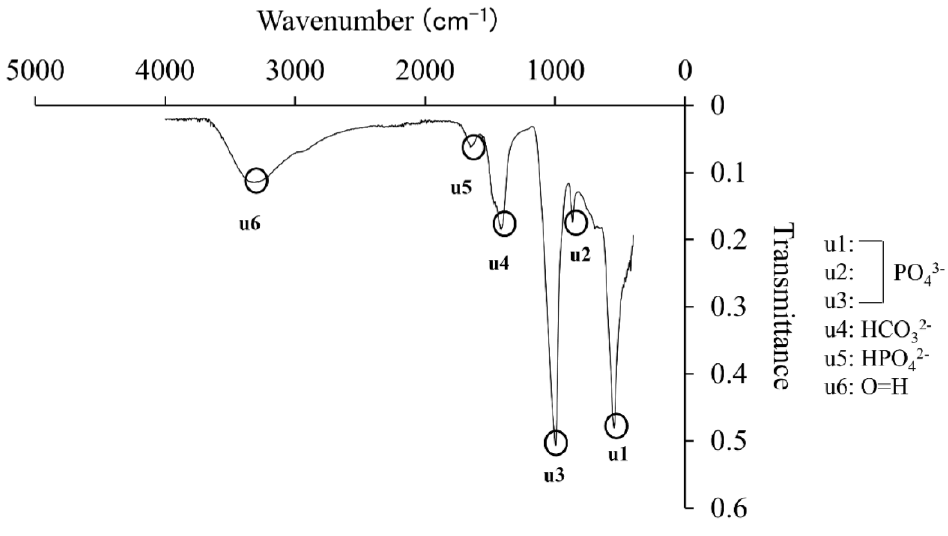
Figure 6. FT – IR analysis of precipitate.